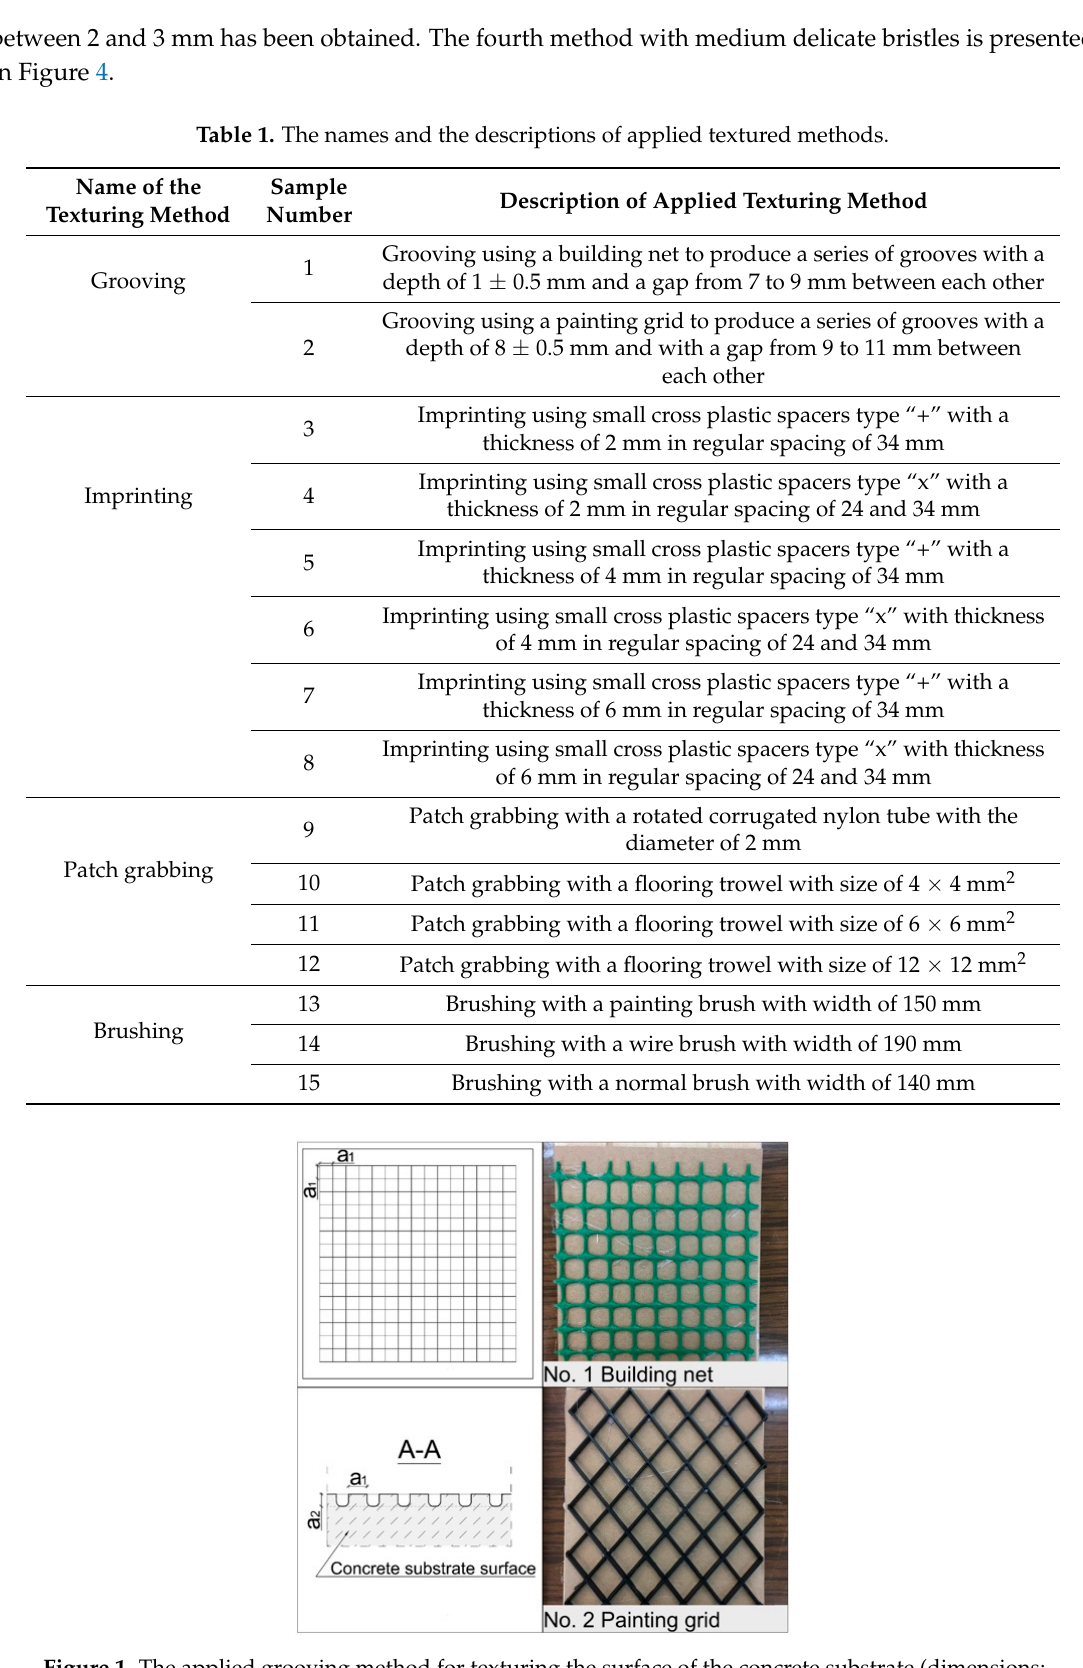
Table 1. The names and the descriptions of applied textured methods.